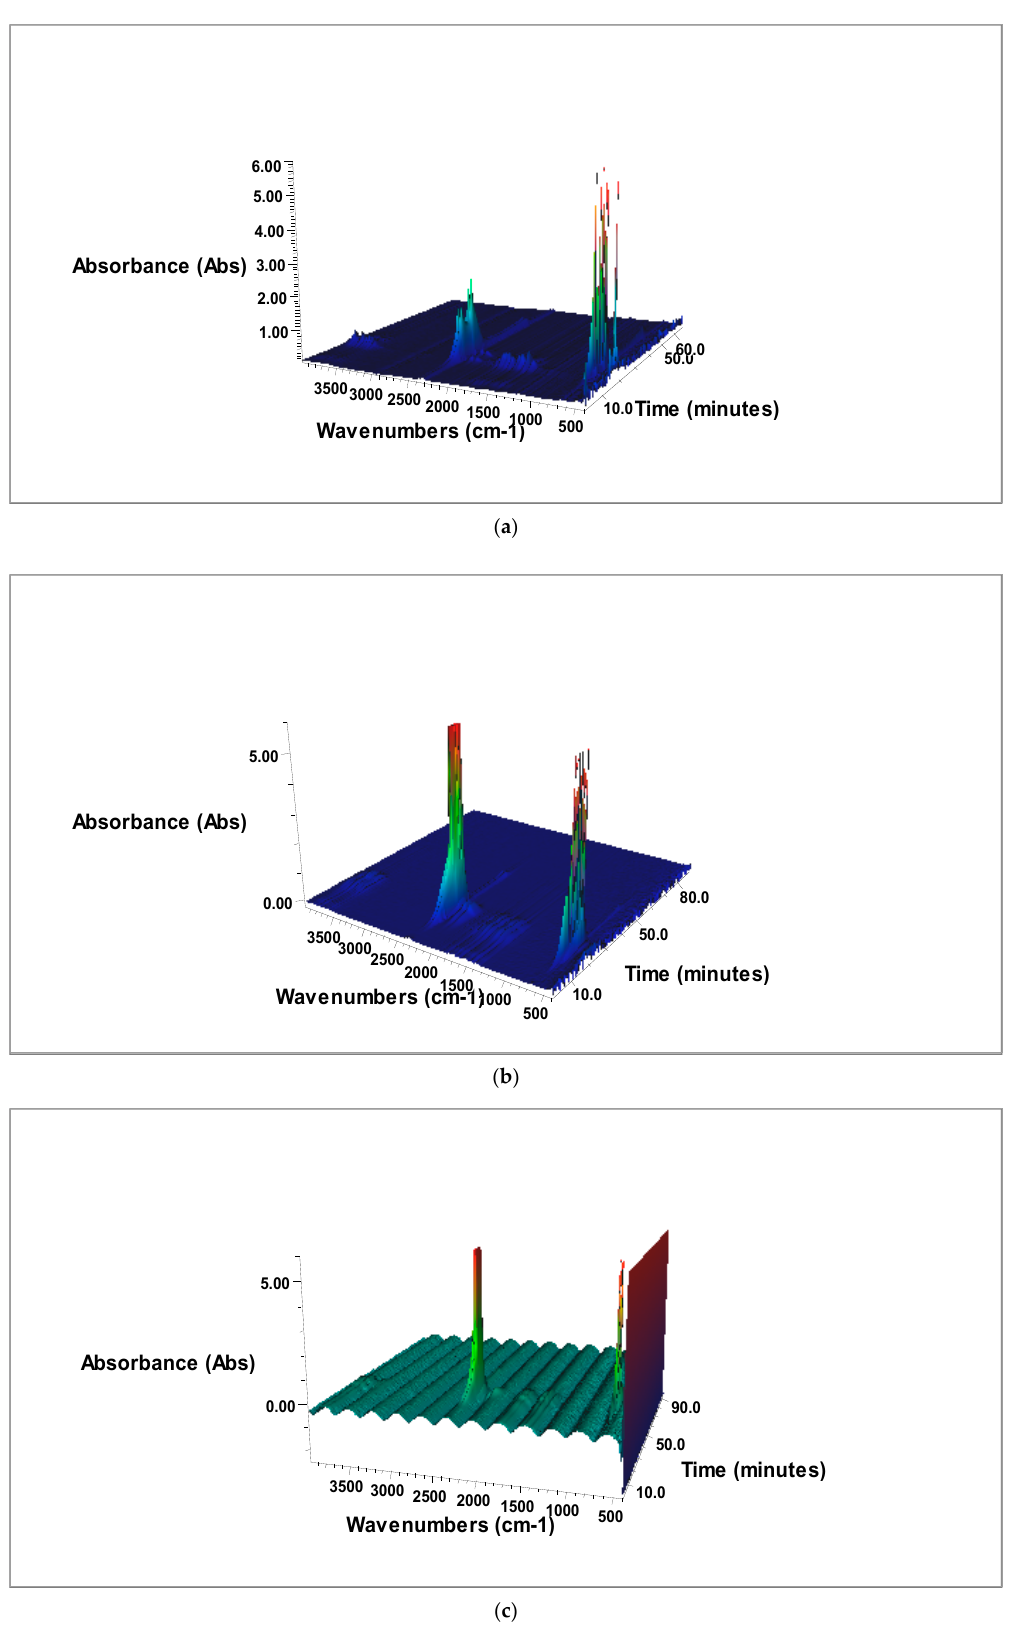
Figure 6. FTIR images showing release of combustion gases leaving ( a ) raw miscanthus, ( b ) SP-400-30, ( c ) PCI coal.